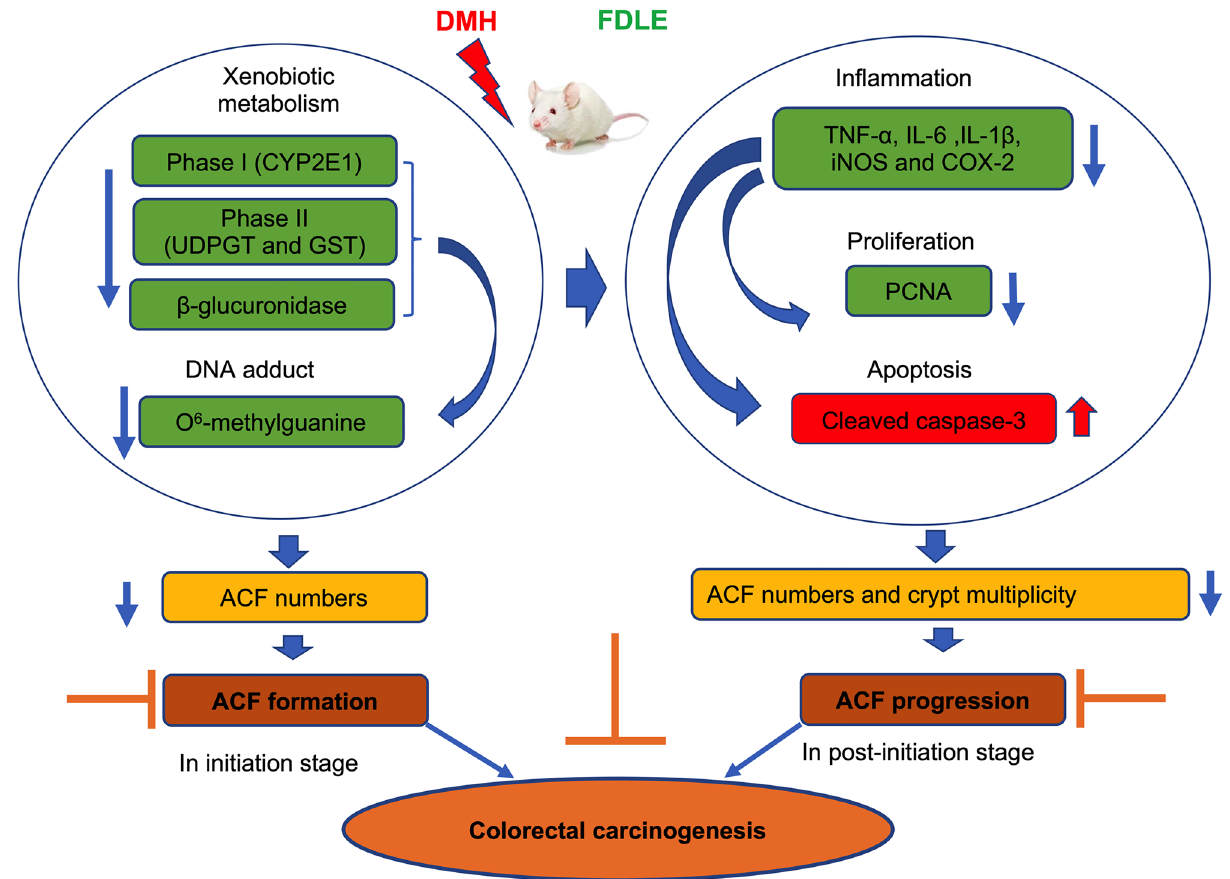
Figure 6. The chemopreventive mechanism of FDLE in DMH-induced rat colorectal carcinogenesis in the early Measurement of known phenolic and flavonoid concentration. The phenolic and flavonoid finger- print of FDLE were determined by HPLC, according to the method of Shao et al. 55 . The extract was determined for the existence of phytochemical contents by HPLC using a C18 column (250 × 4.6 mm, 5 μm) (Agilent Tech- nologies, Santa Clara, CA, USA). The chromatographic separation was carried out using the isocratic mode of mobile phase A (1% acetic acid in water) and mobile phase B (100% acetonitrile) with a total run time of 50 min for detection with a flow rate of 0.7 mL/min. The gradient system used was 90% A in 0 min–60% in 28 min, followed by 40% in the next 39 min and 10% in the next 50 min. The extract of 10 mg/mL dissolved in 1 mL of MeOH was injected into the column and phytochemical contents at 280 nm were detected. The peak area and retention time of the extract sample were evaluated as the comparison with the standard curve (apigenin and chlorogenic acid). Animals model and protocol approving. The male Wistar rats (4–5 weeks of age, weighing 80–100 g) used in this study were purchased from Nomura Siam International, Thailand. Rats were housed in cages in an air-conditioned room (25–30 °C) with exposure to 12/12-h light/dark cycle. The animal treatment protocol was approved by the Animal Ethics Committee, Faculty of Medicine, Chiang Mai University, Thailand (code: 04/2562). Colorectal cancer induction and experimental protocol and treatment schedule. Initiation pro‑ tocol. Rats were divided into five groups (10 rats each). The control groups (groups 1 and 5) received a normal diet (negative control) and only a high dose of FDLE (treatment control) with 0.9% normal saline solution (NSS) injection, respectively. In the experimental groups, positive control (group 2) rats received a normal diet. Rats in group 3 and 4 received FDLE of 100 and 500 mg/kg bodyweight (equal to chlorogenic acid 2.1 and 10.5 mg/ kg body weight), respectively, for 1 week before the first injection of DMH and continued for 5 weeks. All ex- perimental rats were injected with DMH (40 mg/kg of body weight), subcutaneously, once a week at weeks 1 and 2. Feces of rats from each group were directly collected for β-glucuronidase activity measurement. Twelve hours after the second DMH injection (2 weeks), five rats of each group were sacrificed using Zoletil 100, a combination of tiletamine and zolazepam, at 20 mg/kg of body weight. The liver and colon were collected for xenobiotic metabolism enzyme activity and DNA adduct determination. After 5 weeks, the remaining six rats